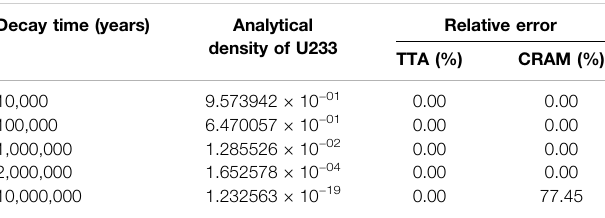
TABLE 5 | Uranium-233 density for various decay times and relative errors.